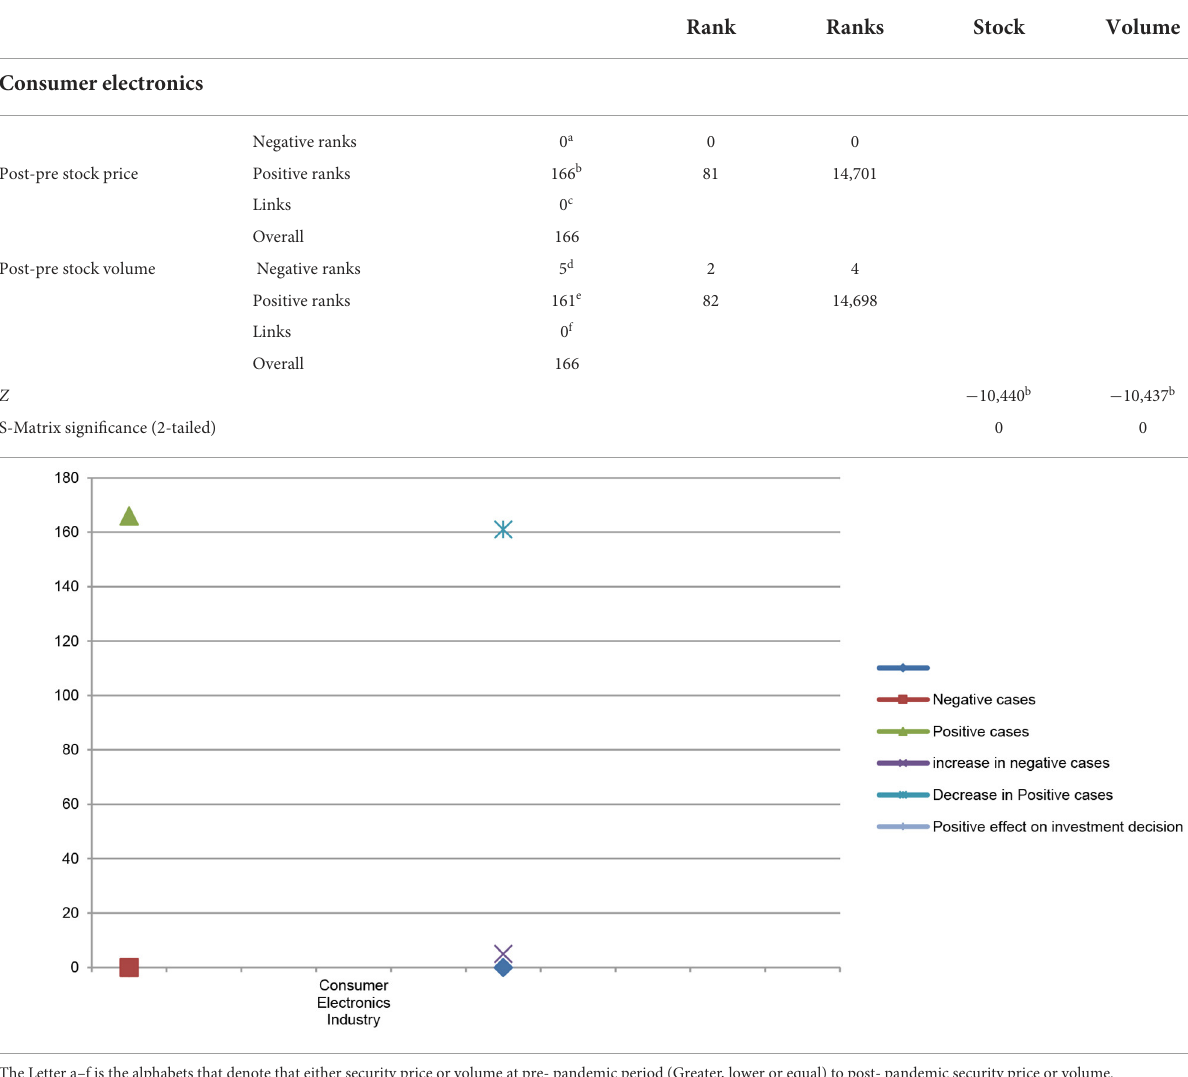
TABLE 8 Multiple regression of the consumer electronics industry.